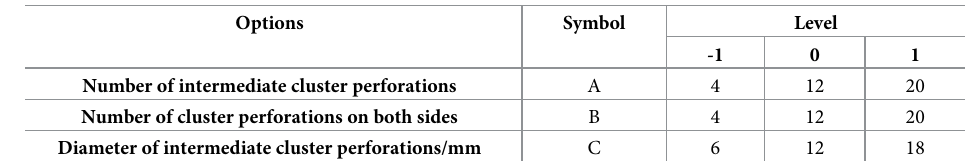
Table 2. Design factors and